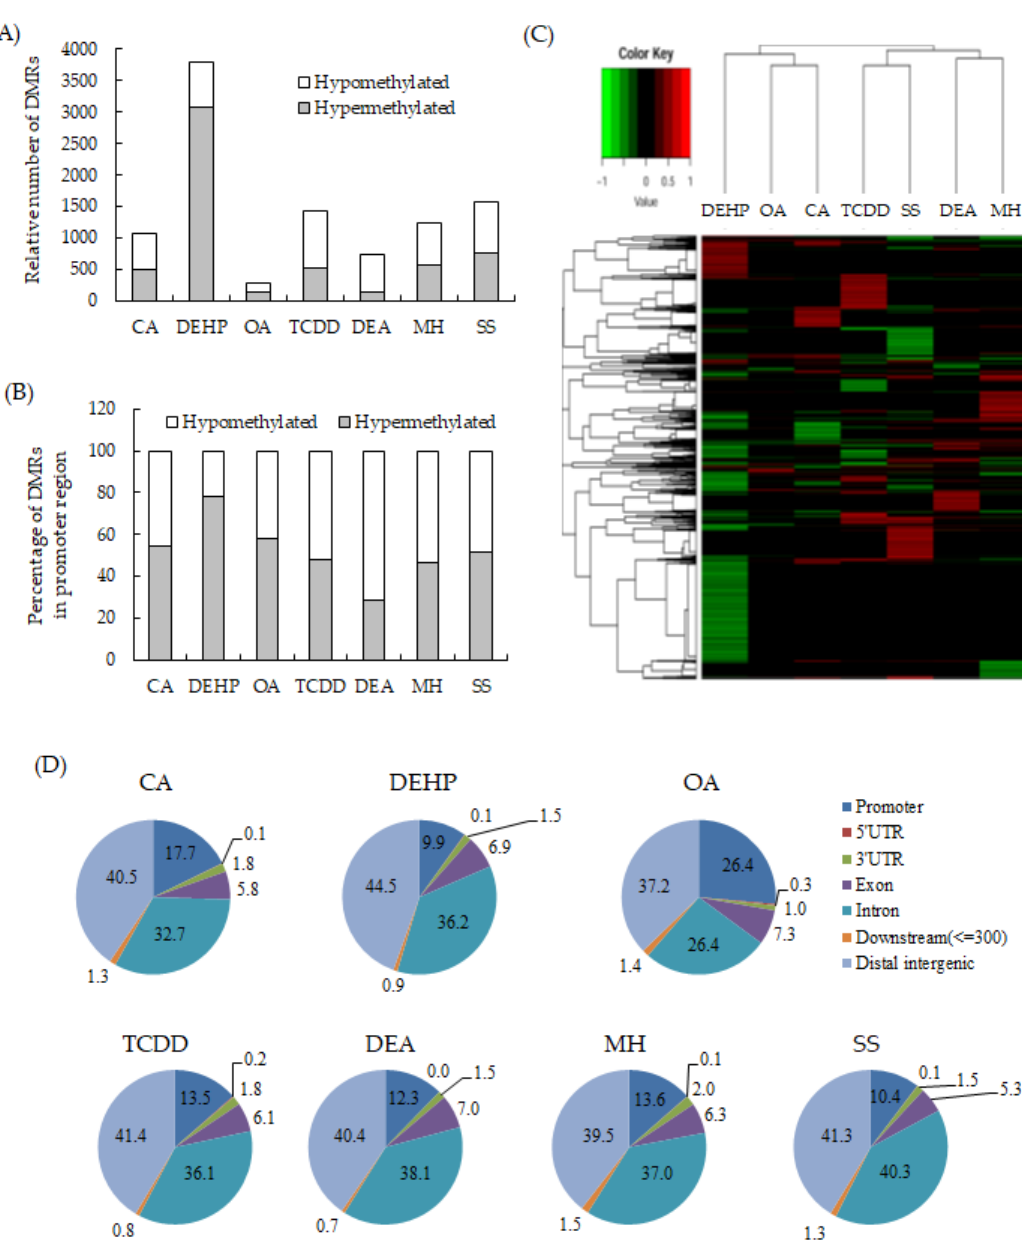
Figure 1. Identification and distribution of the differentially methylated regions (DMRs) specific to each non-genotoxic carcinogen (NGTXC) during the cell transformation. ( A ) Histogram of the distribution of the relative number of hypermethylated and hypomethylated DMRs per NGTXC. ( B ) Histogram of DMRs in the promoter region (−1500–1500). In ( A , B ), the DMRs that were unique to each NGTXC-induced transformed focus were separated by methylation status and classified as hypermethylated or hypomethylated with respect to the untransformed cells. ( C ) The heatmap of the DNA methylation level at DMRs specific to each NGTXC. Each column represents a different NGTXC, and each row represents a different DMR specific to each NGTXC. The red color represents hypermethylation, while the green color represents hypomethylation. ( D ) The distribution of DMRs in different genomic regions: 3′-UTR, 5′-UTR, exon, intron, intergenic, promoter, and downstream (≤300).